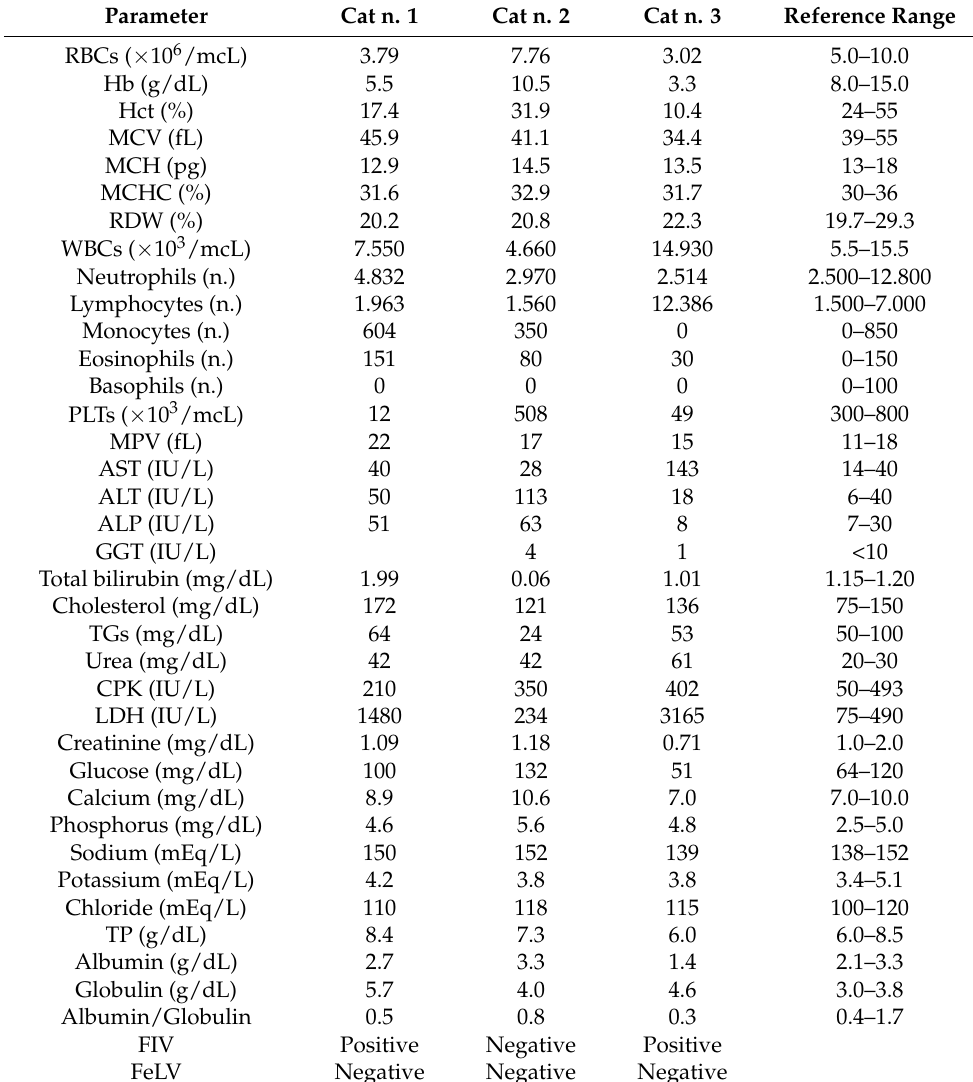
Table 1. Cell blood count, biochemical analysis and rapid enzyme-linked immunosorbent assay test for FIV and FeLV of three domestic cats in central